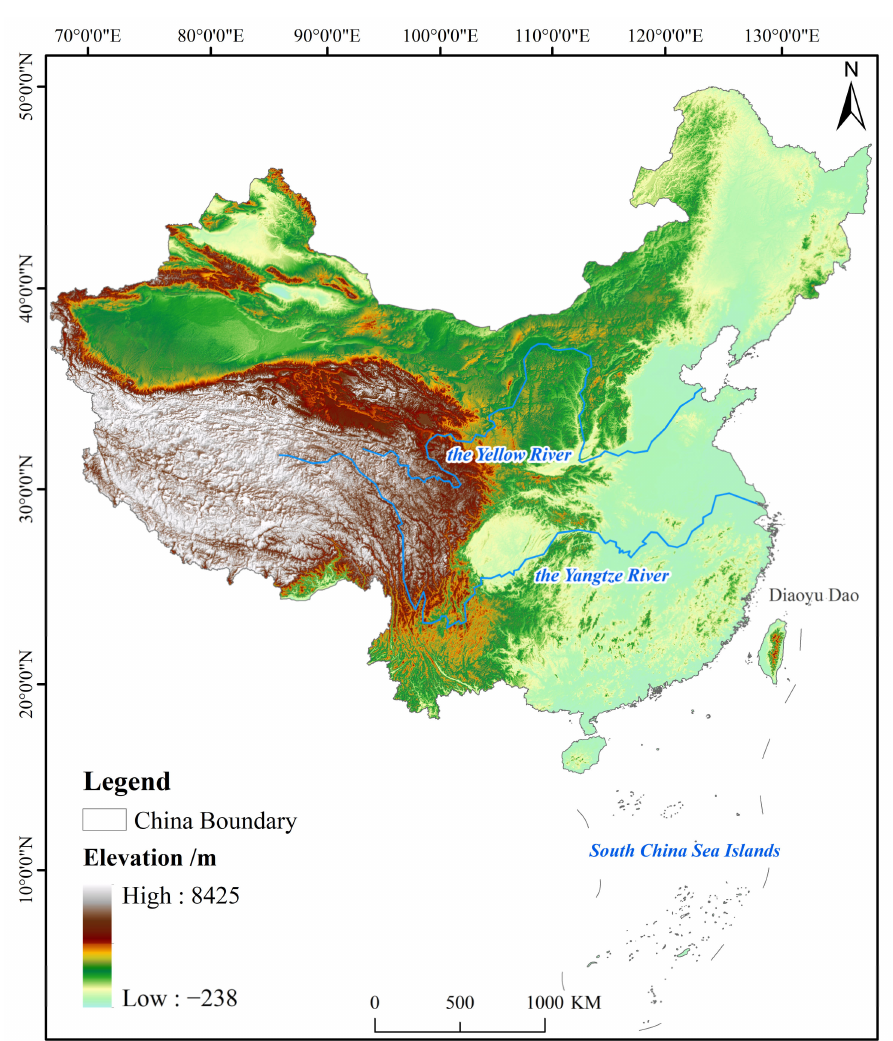
Figure 1. Location of the study